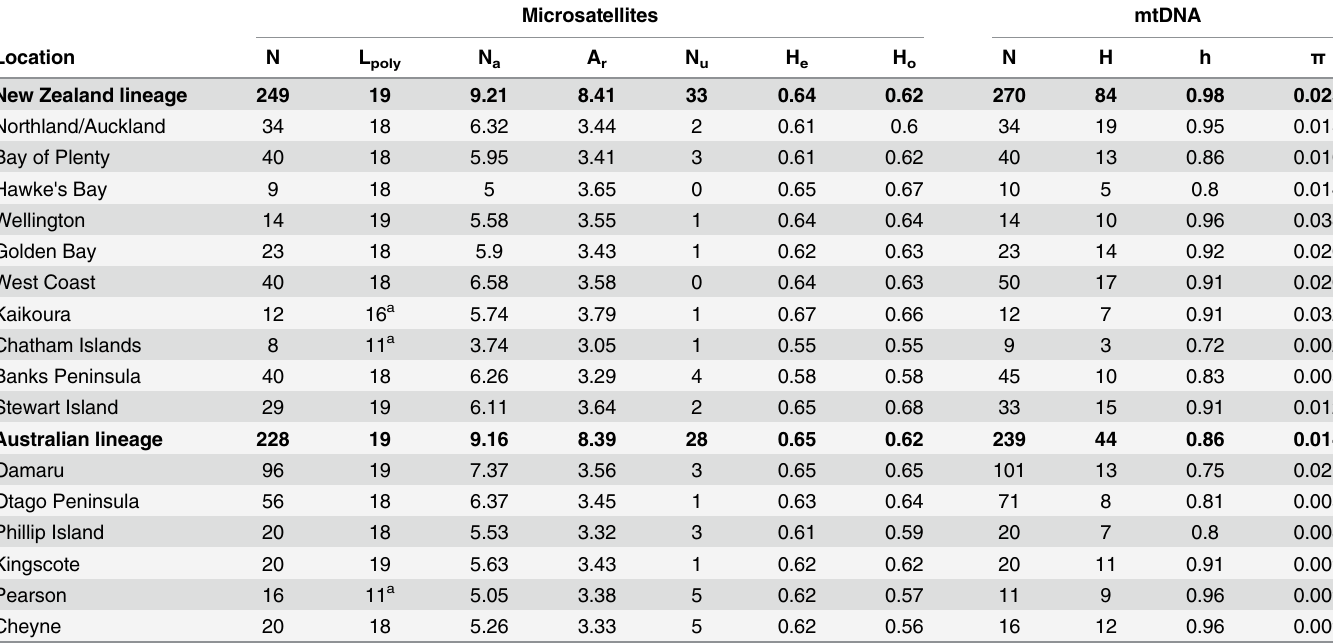
Table 1. Genetic variation within E . minor samples at 19 microsatellite loci and mtDNA control region. Microsatellites mtDNA Location